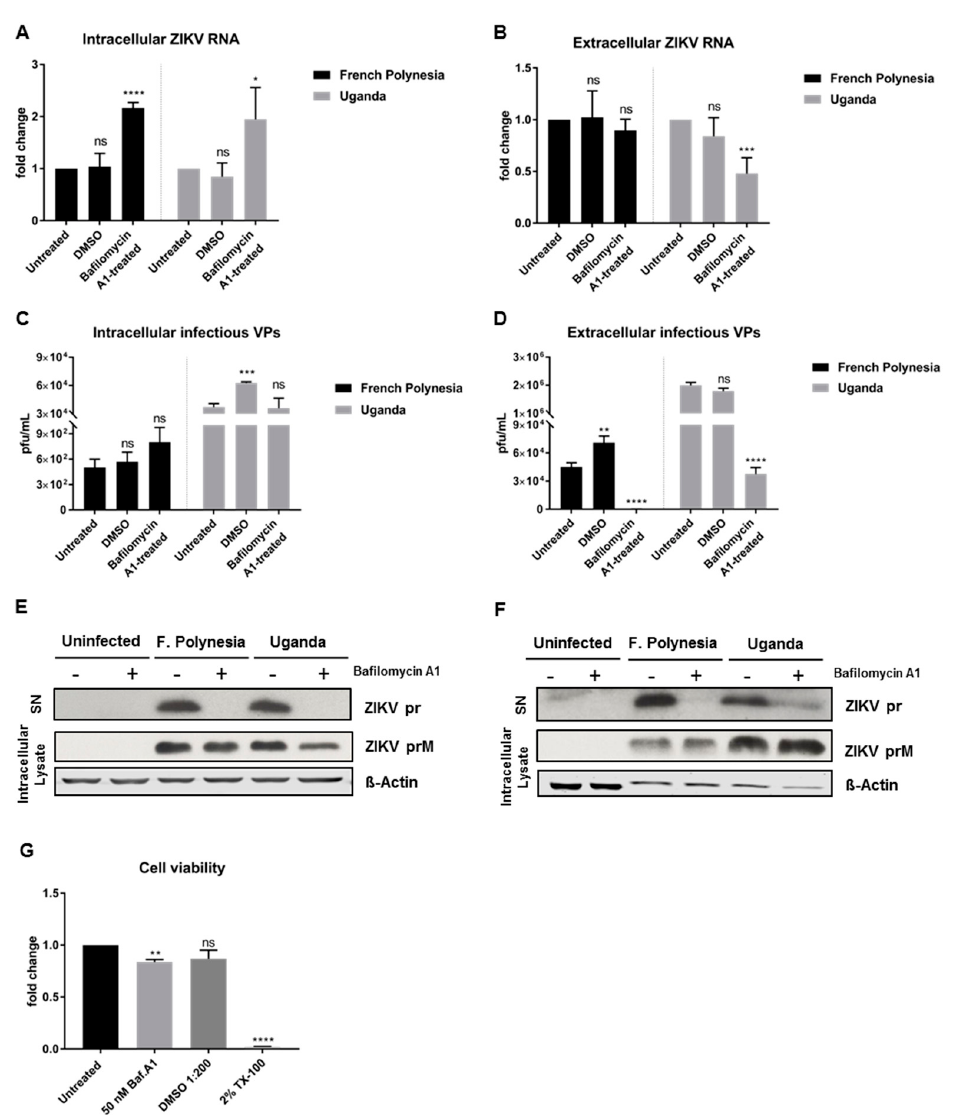
Figure 3. Bafilomycin A1 treatment of ZIKV-infected A549 cells affects the infectiveness of the supernatant. ( A ) Quantification of the amount of intracellular ZIKV RNA of A549 cells infected with either the French Polynesia or the Uganda strain for 72 h and treated with 50 nM bafilomycin A1 (24 h treatment). Quantification was performed by RT-qPCR and the amount of ZIKV RNA was normalized to the amount of the RPL27 transcripts. DMSO was included as vehicle control and infected untreated cells were used as control; ( B ) Quantification of the amount of extracellular ZIKV RNA of A549 cells infected with either the French Polynesia or the Uganda strain for 72 h and treated with 50 nM bafilomycin A1 (24 h treatment). Quantification was performed by RT-qPCR. DMSO was used as vehicle control and infected untreated cells served as control; ( C ) Quantification of the number of intracellular infectious viral particles (VPs) from A549 cells infected with either the French Polynesia or the Uganda strain for 72 h and treated with 50 nM bafilomycin A1 (24 h treatment). Quantification was performed in Vero cells by plaque assay and the number of infectious viral particles is expressed in plaques forming units per mL (pfu/mL). DMSO was used and vehicle control and infected untreated cells served as control; ( D ) Quantification of the number of extracellular infectious viral particles (VPs) from A549 cells infected with either the French Polynesia or the Uganda strain for 72 h and treated with 50 nM bafilomycin A1 (24 h treatment). Quantification was performed in Vero cells by plaque assay and the number of infectious viral particles is expressed in plaques forming units per mL (pfu/mL). DMSO was used as vehicle control and infected untreated cells served as control; ( E ) A549 cells were infected with either the French Polynesia or the Uganda strain and